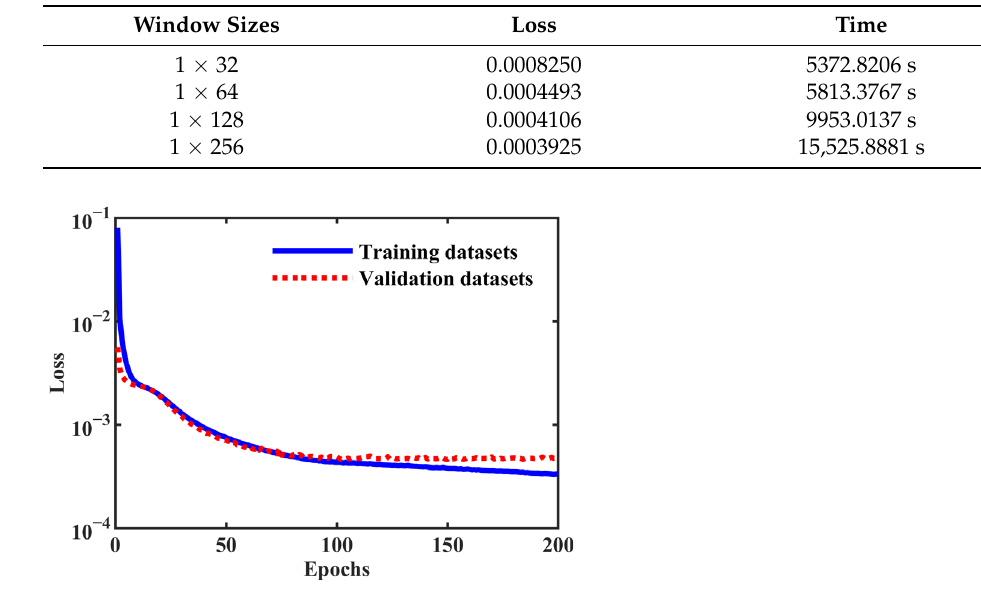
Figure 9. The loss of the ResNet for MT noise suppression. Table 4. The average denoising SNR of all validation datasets for different